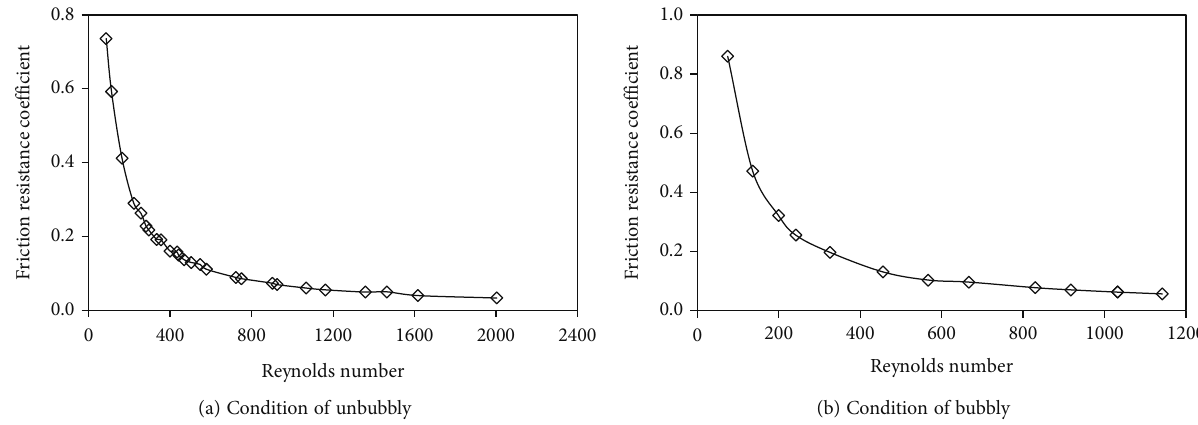
Figure 4: Matching relationship between the frictional factor and generalized Reynolds number. Table 1: Relationship of CO foam rates on condition of ground 2 surface and downhole. CO foam rates on the condition of 2 the ground surface (m 3